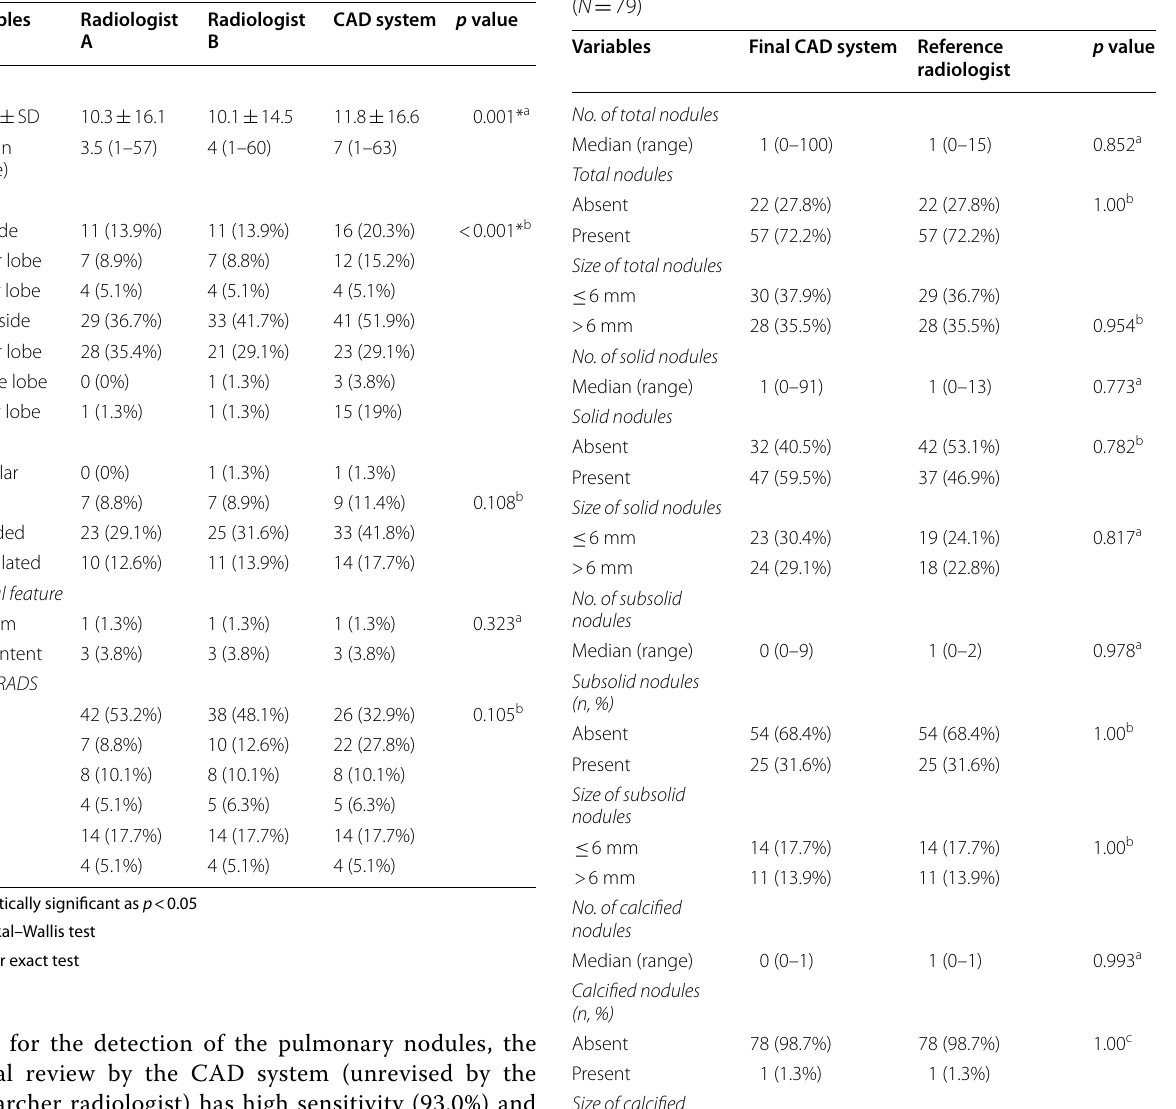
Table 3 Characteristics of the largest nodule as diagnosed by radiologist A, radiologist B and CAD system ( N